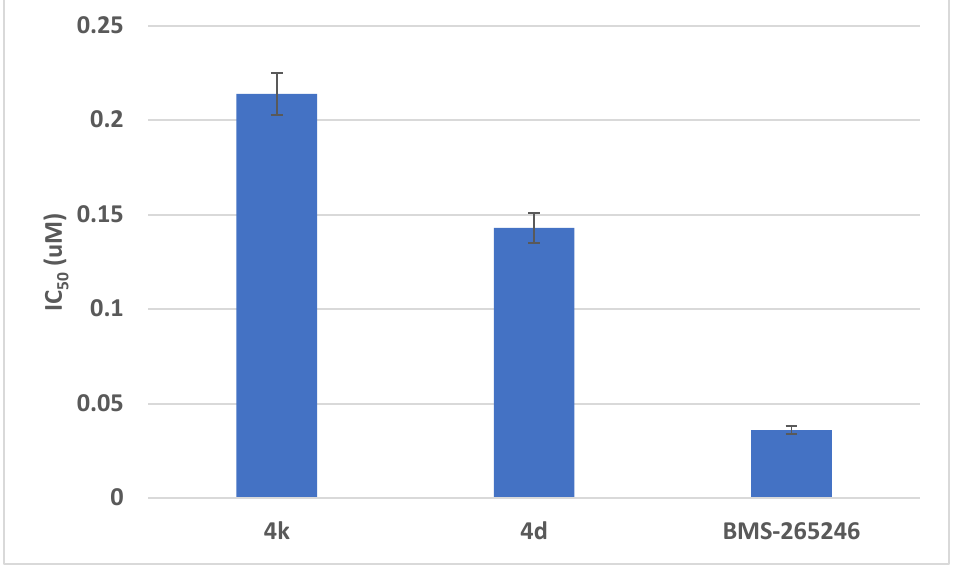
Figure 16. IC 50 values of 4d , 4K and BMS-265246 against CDK2. Thus, our results for the kinase inhibitory assays are in agreement with the previously reported studies, which indicated that tropane–pyran hybrid structures could be considered as promising core scaffolds for developing new anticancer agents acting as CDK2 inhibitors [37].